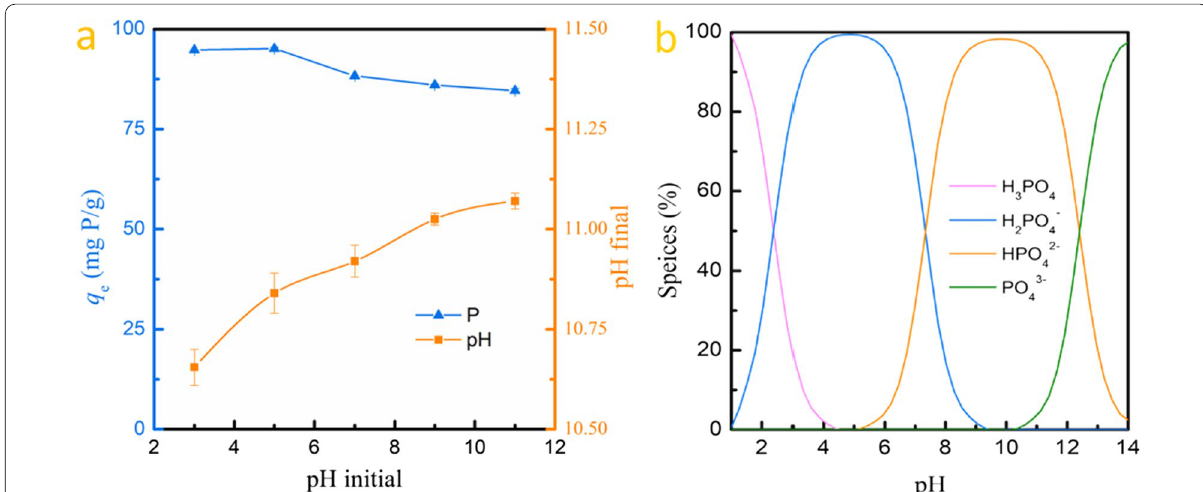
Fig. 2 Effect of solution pH on phosphorus adsorption by MFBC and changes in pH after adsorption ( a ), components distribution of phosphate (100 mg/L) system at different pH conditions ( b